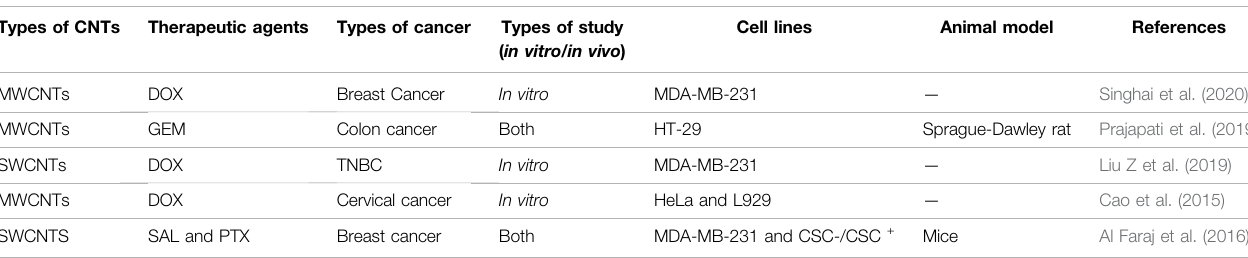
TABLE 4 | Summary of CNT-targeted CD44